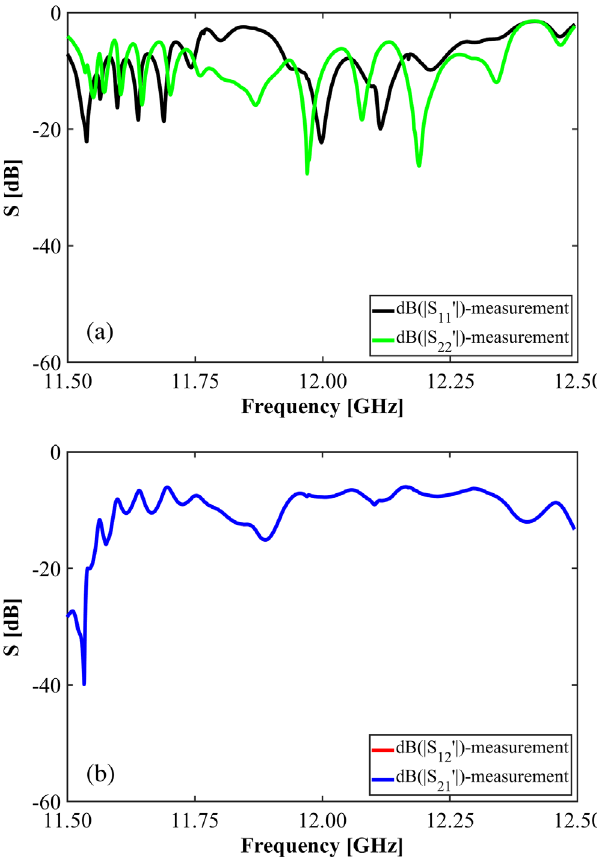
FIG. 27. Comparison between simulated and measured electric field magnitude, for injecting rf power from ports 1 and 3 (a), from ports 2 and 4 (b),